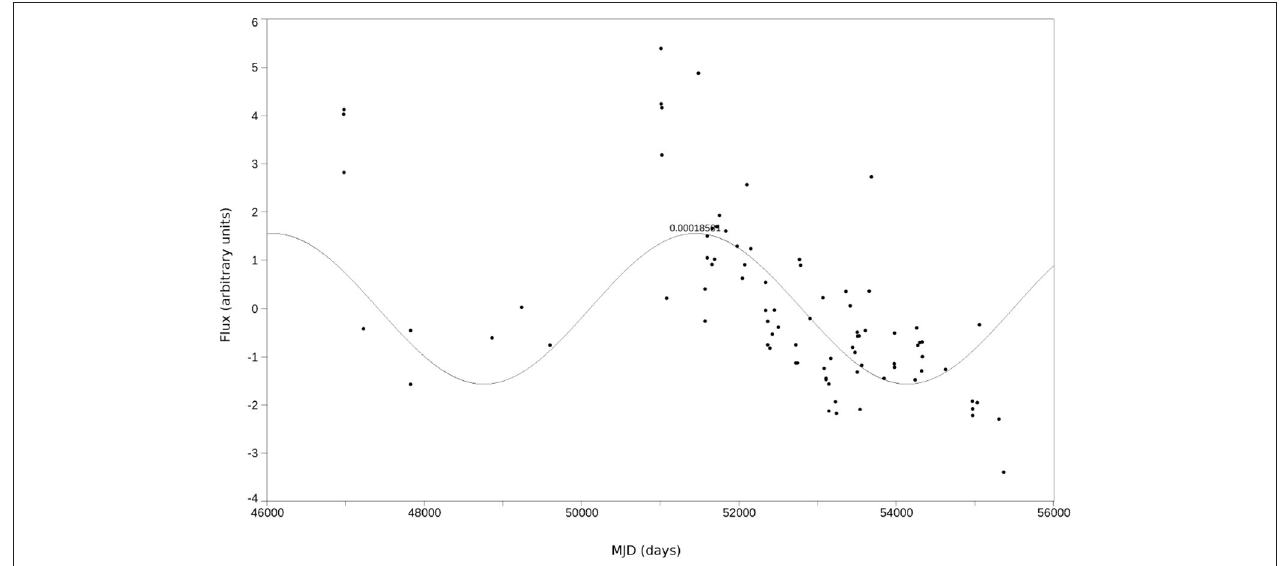
FIGURE 3 | Long term variability analysis of Arp 102B light curve after trend removal correction fitted with the sine function with the period of about 14